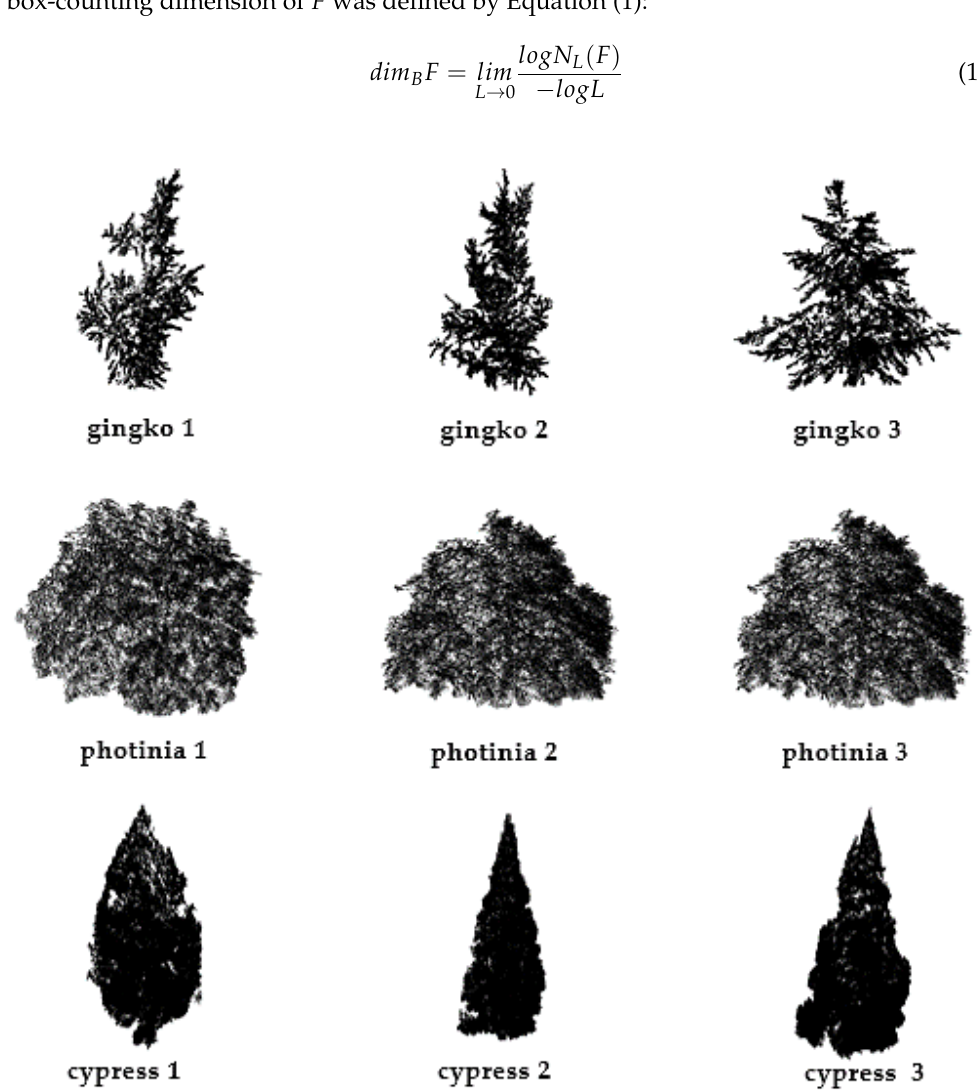
Figure 2. Experimental data sets include three gingko trees, three photinia trees and three cypress trees. In this study, considering the characteristics of terrestrial laser point cloud data of individual trees, we use multi-scale cube coverage that based on the range of an individual tree, to calculate the fractal dimension of an individual tree. The schematic diagram is shown in Figure